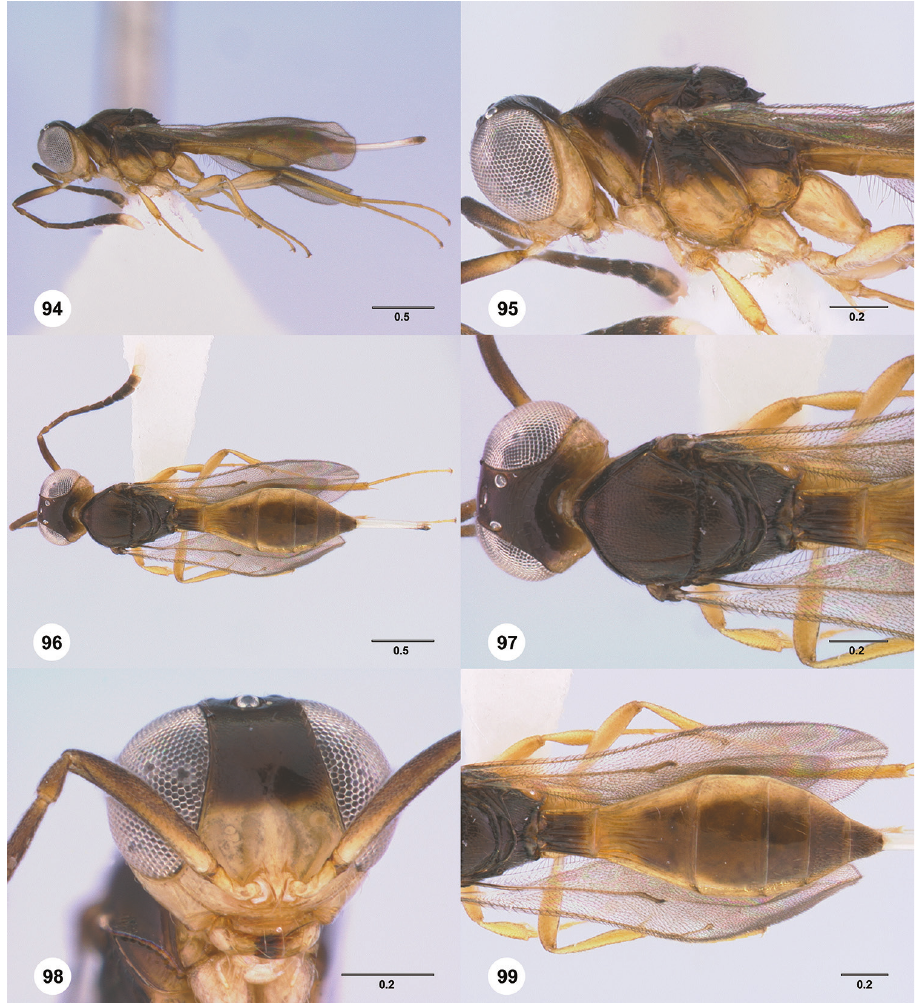
T2 in female: reaching the middle of T2 medially. Sculpture of T3: smooth. Shape of T6 in female: short, wider than long. Sculpture of S3: